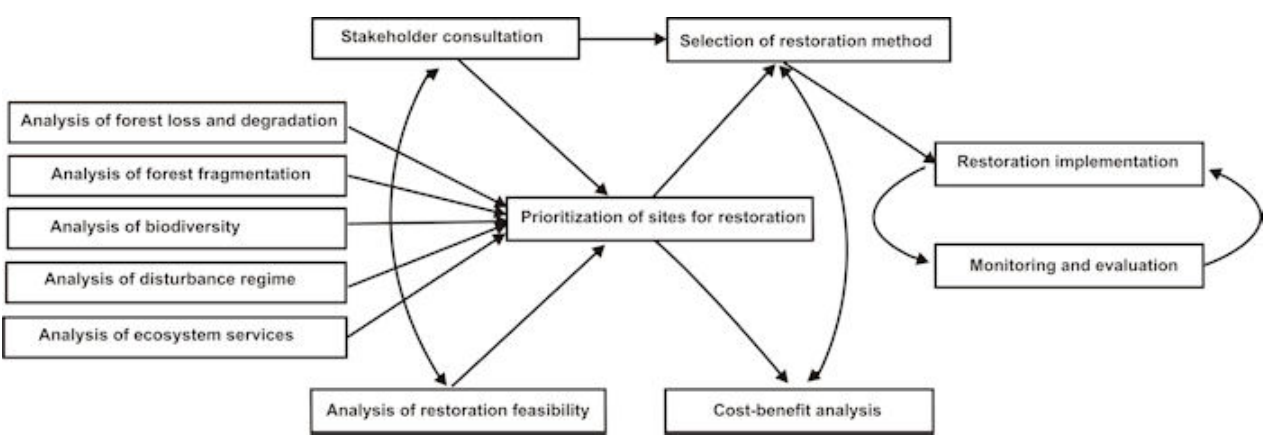
Fig. 1 . The process of FLR, and its key